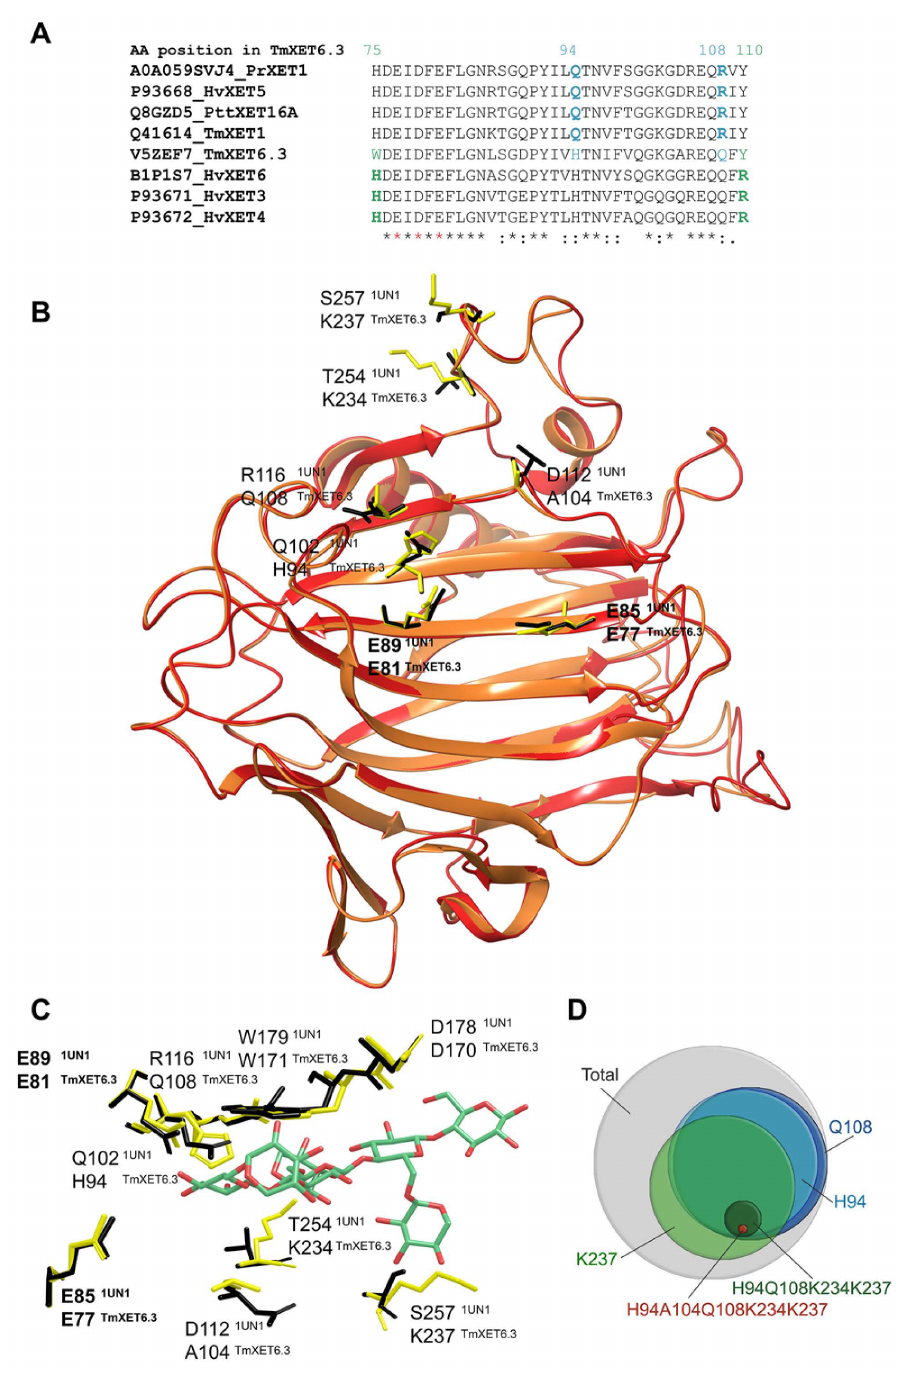
Figure 3. Structural basis of hetero-transglycosylation reactions catalysed by plant XETs with neutral acceptor substrates. ( A ) sequence alignment of specific and nonspecific XETs to indicate target residues destined for mutagenesis in TmXET6.3 to suppress the hetero-transglycosylation activity with neutral acceptors (blue, mutations H94Q and Q108R) and evoke the hetero-transglycosylation activity with the charged [ α (1-4)GalA p ] 5 acceptor (green, mutations W75H, Y110R). Red asterisks mark catalytic residues [125]; ( B ) superposition of poplar PttXET16A (PDB accession 1UN1; red) and the TmXET6.3 model [123] orange; points to di ff erences in residues between the two structures, which are visualised in yellow (PttXET16A) and black (TmXET6;3) sticks; ( C ) interactions of the XXXG acceptor (cpk green) with the residues of PttXET16A (yellow sticks) and TmXET6.3 (black sticks); ( D ) Venn diagram of the occurrence of nonspecific XETs (with detailed residue configurations) based on the analysis of 3394 UniProtKB entries